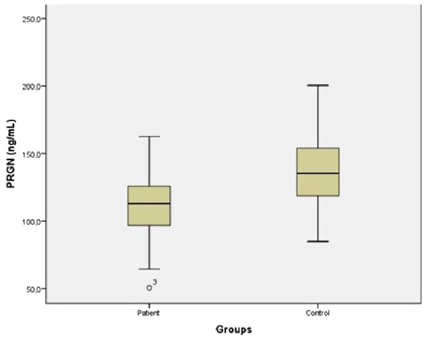
Figure 1. Serum progranulin levels of the control group and patient